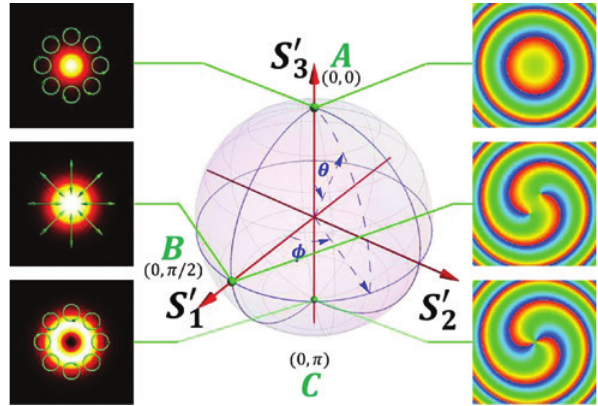
Figure 5: Schematic illustration for the evolution of phase and polarization states on hybrid-order Poincaré sphere. Insets in the right row show the phases of points A, B, and C, respectively. Insets in the left row show the polarization states of the three points. Here, we assume the north pole with state σ = ± 1 and l = 0, while the south pole is with σ = - 1 and l = 1.